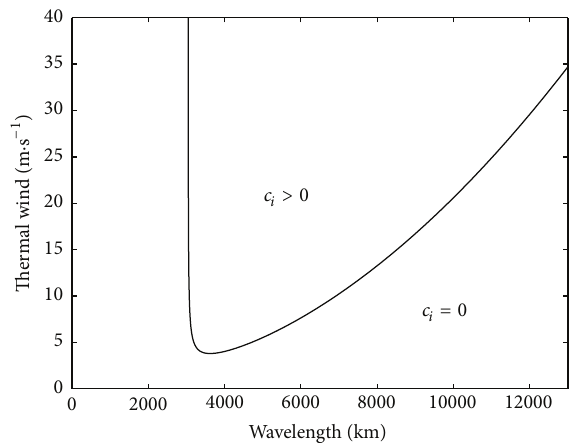
Figure 2: Instability diagram displaying wavelength regions of stable and unstable